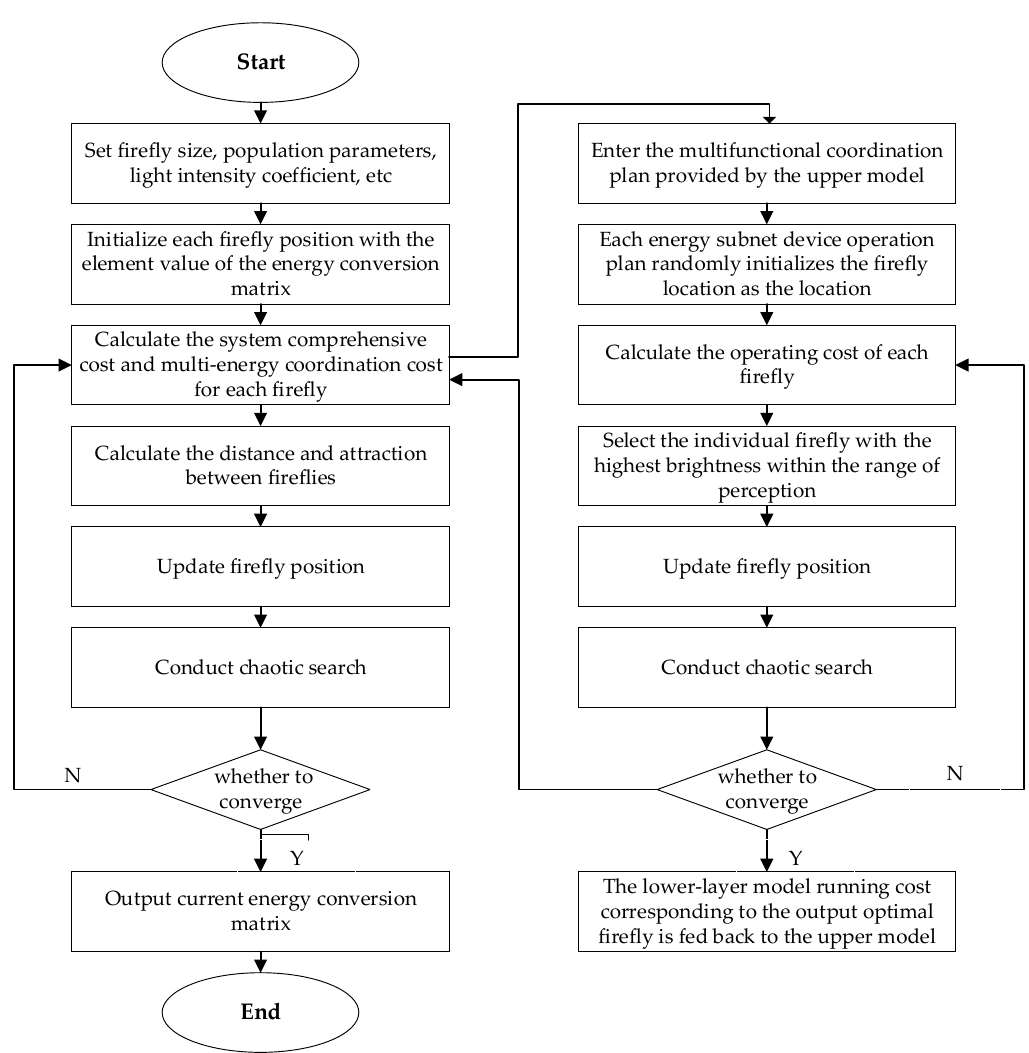
Figure 3. A model solving flow chart based on an improved imperialist competitive algorithm.